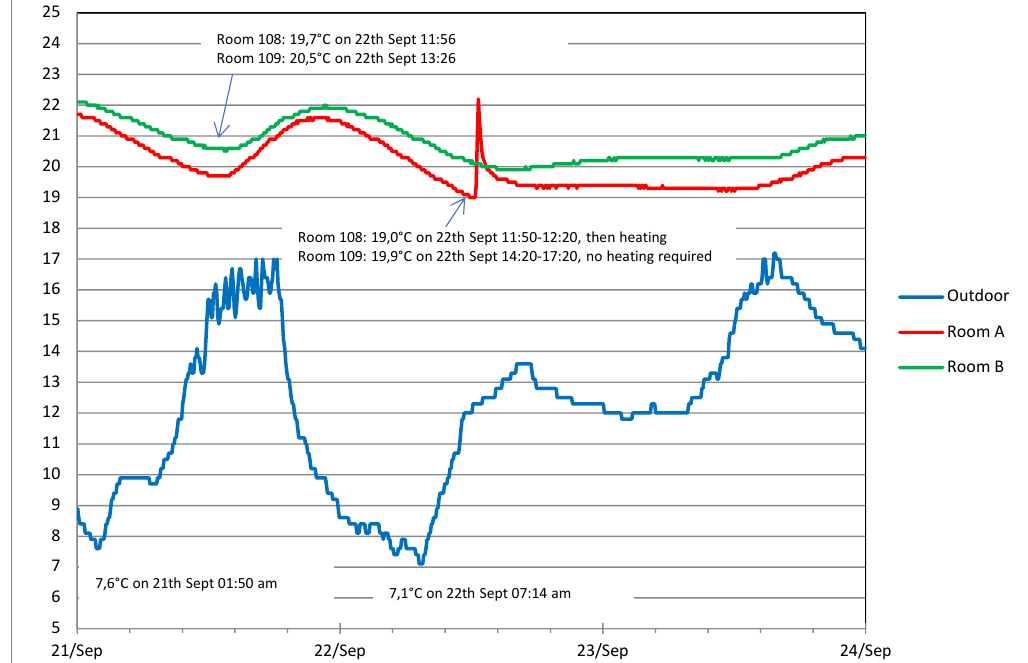
Figure 15. Changes in indoor climate in rooms A and B compared to outdoor temperature during 21–24 September 2017.